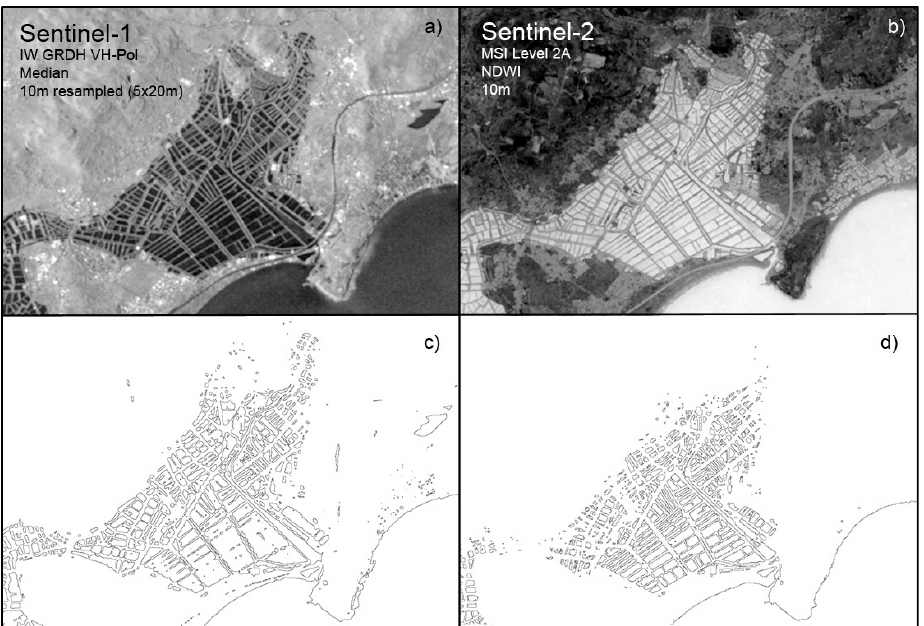
Figure 11. Aquaculture structures as observed from a median backscatter metric derived from a Sentinel-1 time series ( a ), and from a normalized difference water index (NDWI) layer derived from a multispectral Sentinel-2 scene ( b ). Aquaculture objects derived from median backscatter ( c ), and from a Sentinel-2 NDWI layer ( d ).